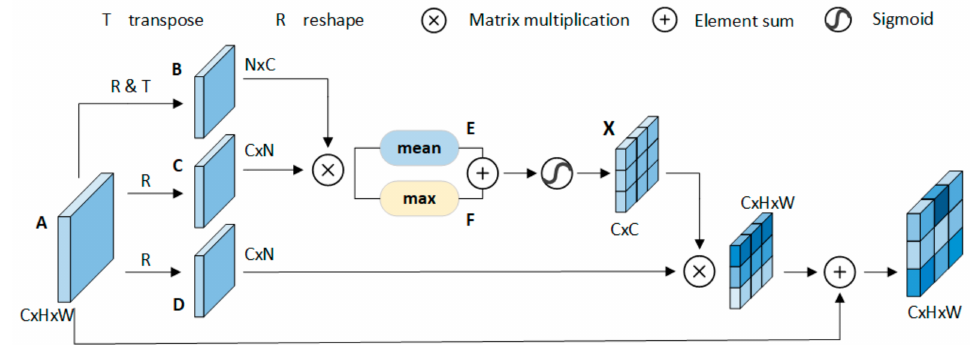
Figure 4. The structure of